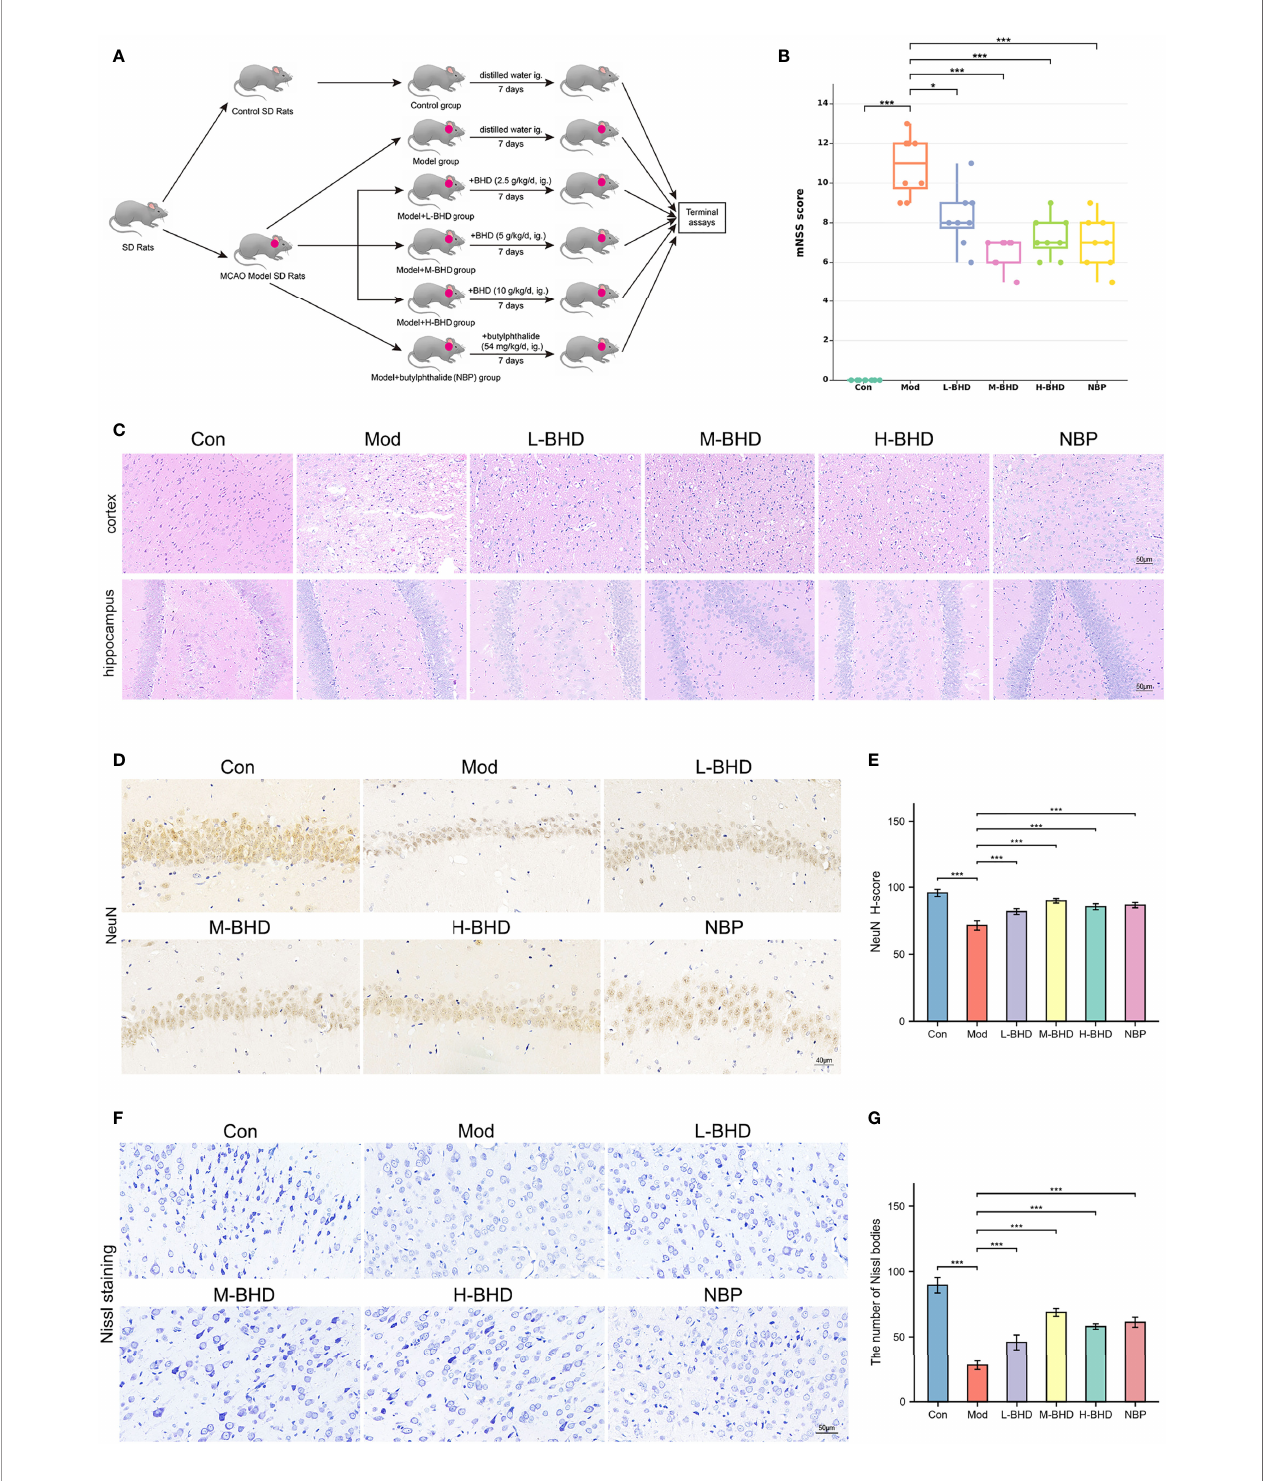
FIGURE 2 | Effects of BHD on the modi fi ed neurological severity score (mNSS), pathological changes and neuronal damage of rats with CI. (A) Animal experimental design. (B) Comparison of mNSS between different groups (n = 8 per group). (C) HE staining at a magni fi cation of 20× (n = 4 per group). (D, E) Immunostaining and quanti fi cation of NeuN-positive cells in the hippocampal CA1 region (n = 4 per group). (F, G) Nissl staining and cell counts of Nissl bodies in the cortical area (n = 4 per group). All the data are presented as the mean ± SD. Differences were assessed by one-way ANOVA and Student ’ s t-test: *** p < 0.001, * p <